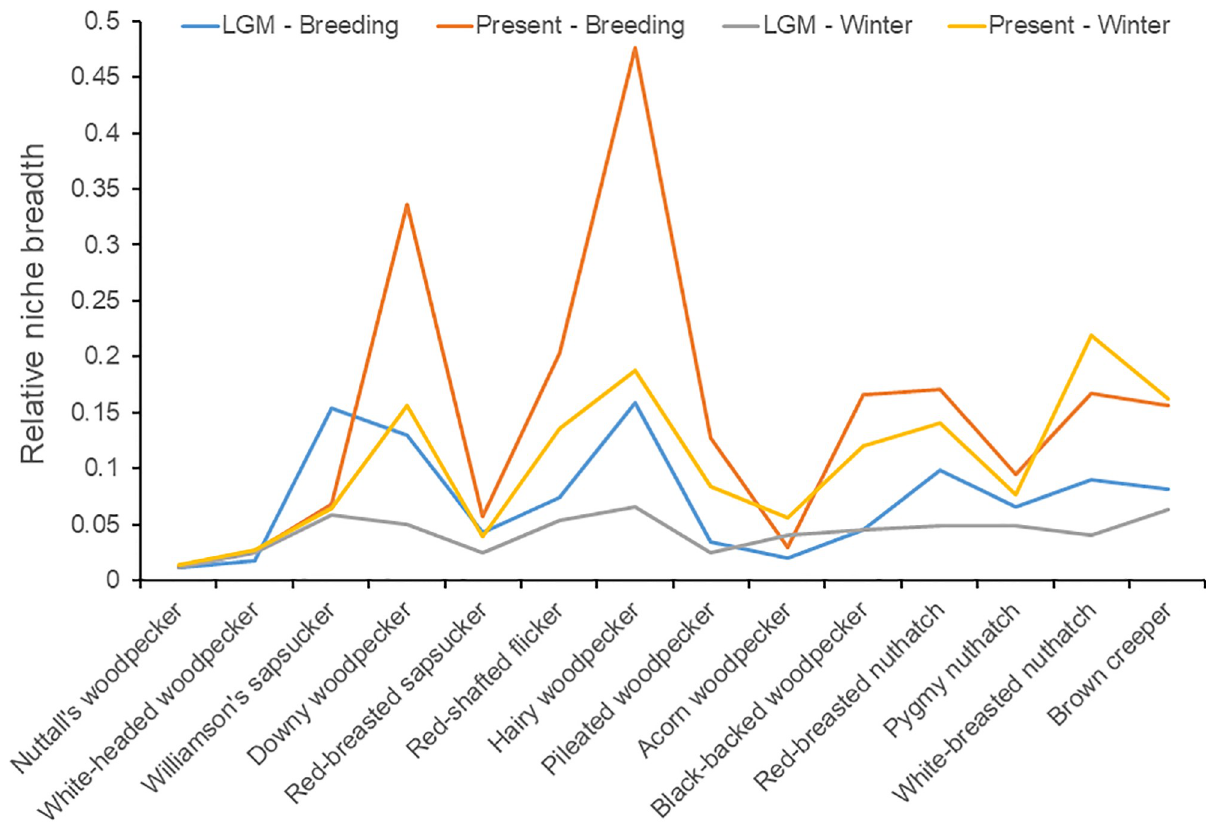
Fig 4. Comparisons of niche breadths in bark-gleaning birds at present and the LGM across seasons.